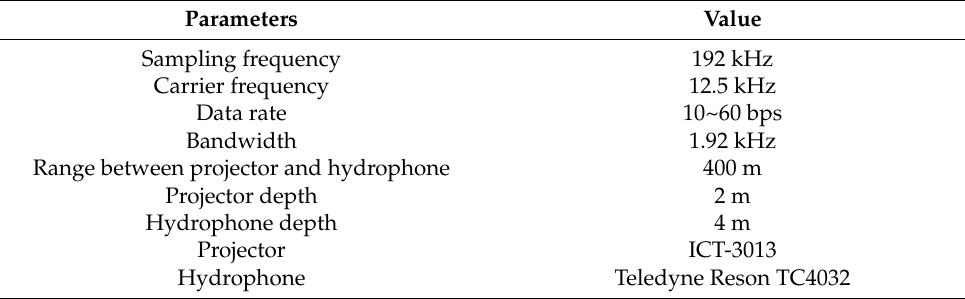
Figure 14. ( a ) Layout diagram of experimental area, ( b ) Experimental setup.